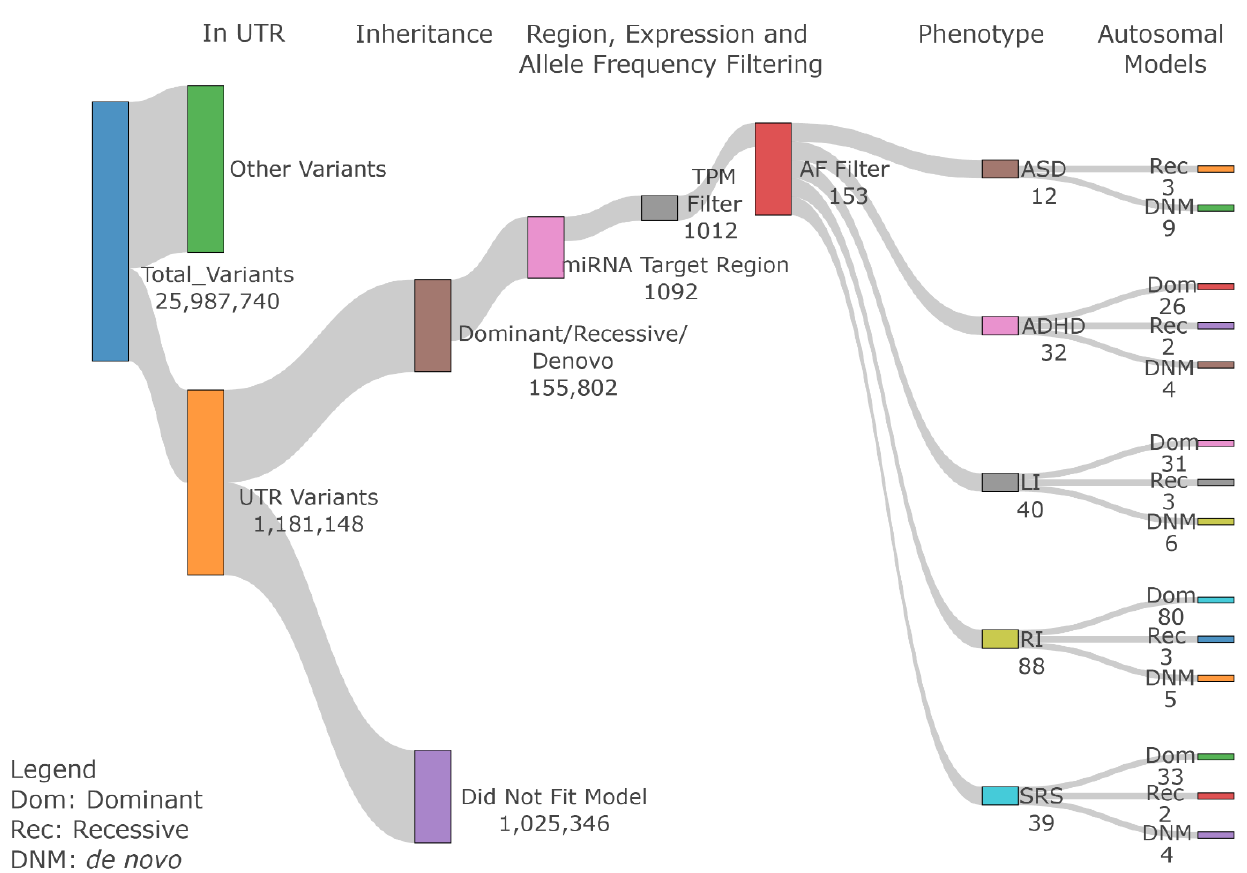
Figure 2 . 3 ′ UTR variant filtering steps. After selecting all variants within 3 ′ UTR regions, we filtered variants based on their inheritance pattern, miRNA target region annotation, brain expression pattern, and population allele frequency to select final candidate variants.